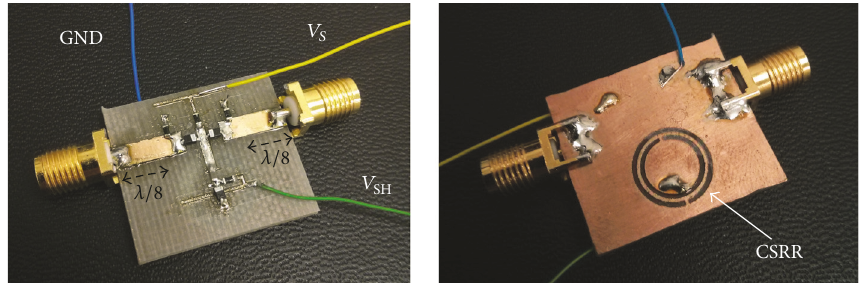
Figure 5: Top and bottom layer pictures of the miniaturized LWA unit cell. The design is etched between two 𝜆 /8 microstrip lines for 𝑆 - parameter